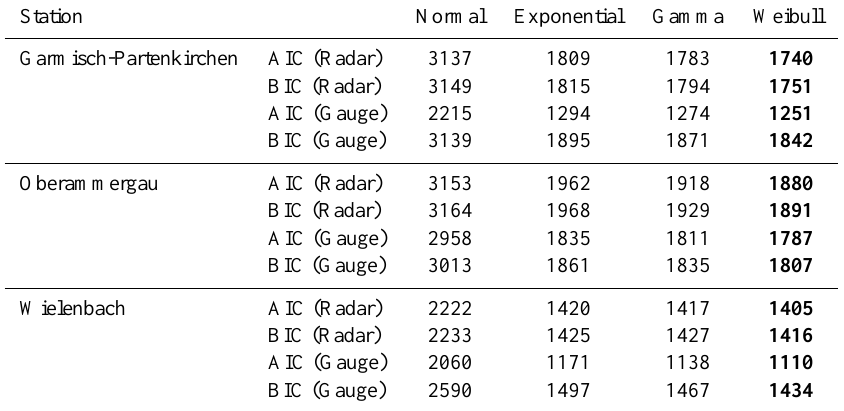
Table 5. Akaike and Bayesian information criteria (AIC and BIC) of radar and gauge (positive pairs only) for selected rain gauge stations and different univariate distribution functions (June, July, and August of 2006 and 2007). Smallest values of AIC/BIC indicate the best fit